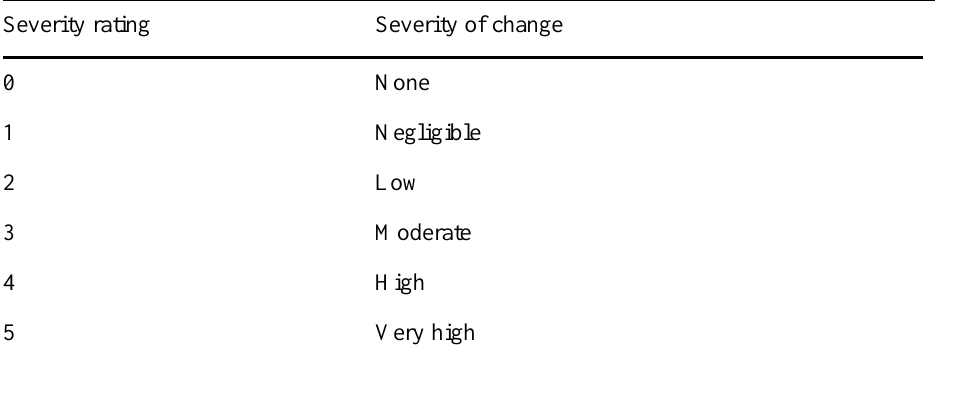
Table 5 . Severity ratings for predictions of change in abundance, area, or concentration of ecosystem variables (King et al.